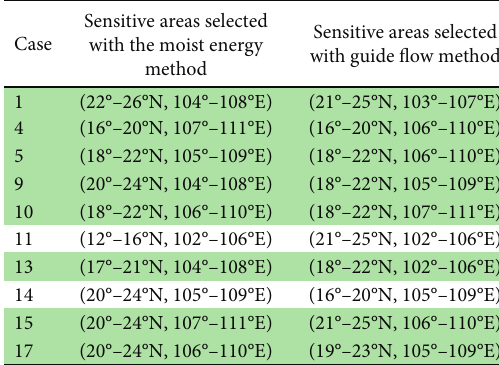
Figure 4: Sensitive area selected with the guide flow method (rectangles in panel (a) and left rectangles in panel (b)), sensitive areas identified by moist energy (unit:1 × 10 5 J the left parts of shadings in both two panels), and the precipitation area (unit: mm, the right parts of shadings in both two panels) overlayed with the 700 hPa wind field in (a) case 4 and (b) case 5. Table 5: Comparison of sensitive areas selected with moist energy method and guide flow method.